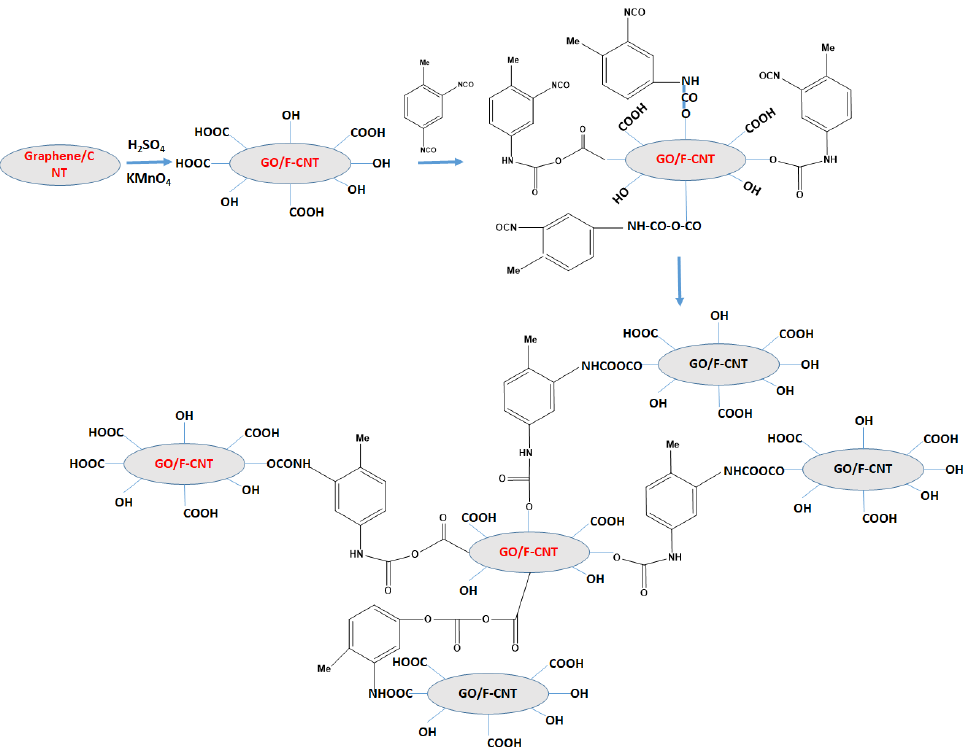
Figure 1. Schematic of graphene CNT functionalization, composite formation with toluene